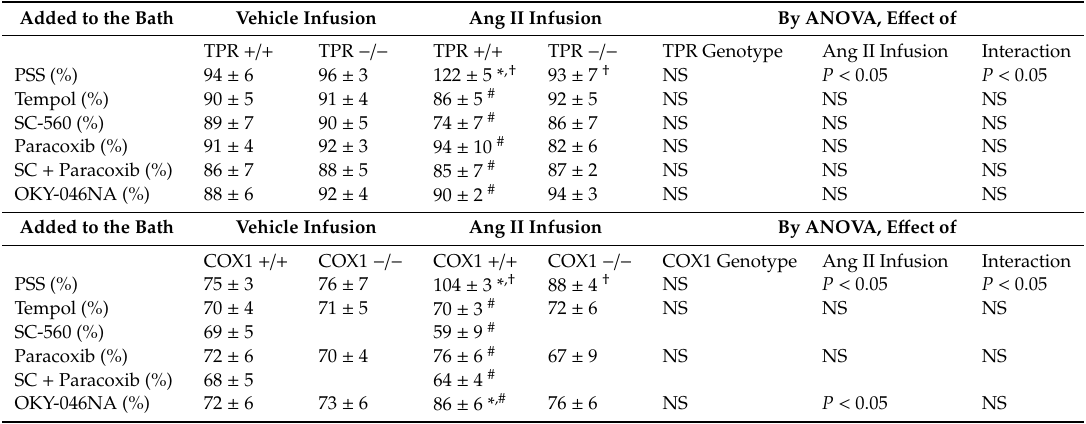
Mean ± SEM, n = 6 / group for contractions, relative to a standard contraction with norepinephrine and potassium (NAK; see Figures 4–6) with a maximum concentration of endothelin 1 (10 − 7 mol · L − 1 ) in mesenteric resistance arterioles incubated for 30 min with PSS or with tempol (10 − 4 mol · L − 1 ), SC-560 (10 − 6 mol · L − 1 ), paracoxib (10 − 5 mol · L − 1 ), or OKY-046NA (10 − 5 mol · L − 1 ). Vessels were from mice infused for 14 days with a vehicle or angiotensin II (400 ng · kg − 1 · min − 1 sc). Compared to the vehicle: *, P < 0.05. Compared to corresponding +/+ mice: † , P < 0.05. Compared to corresponding PSS: # , P <